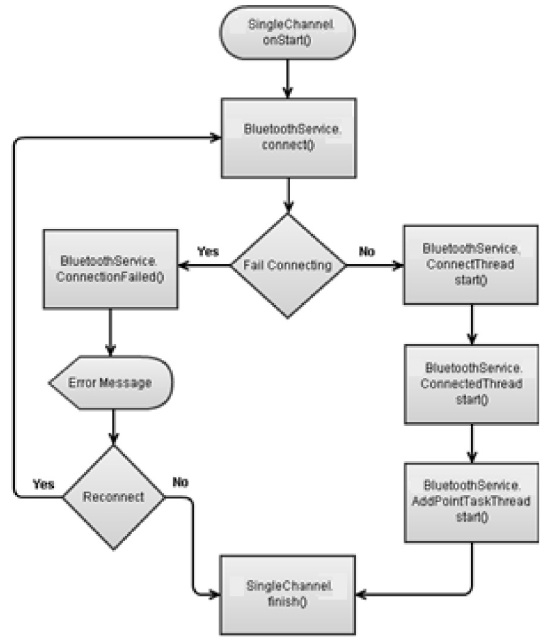
Figure 13. Flowchart associated with mobile GUI.